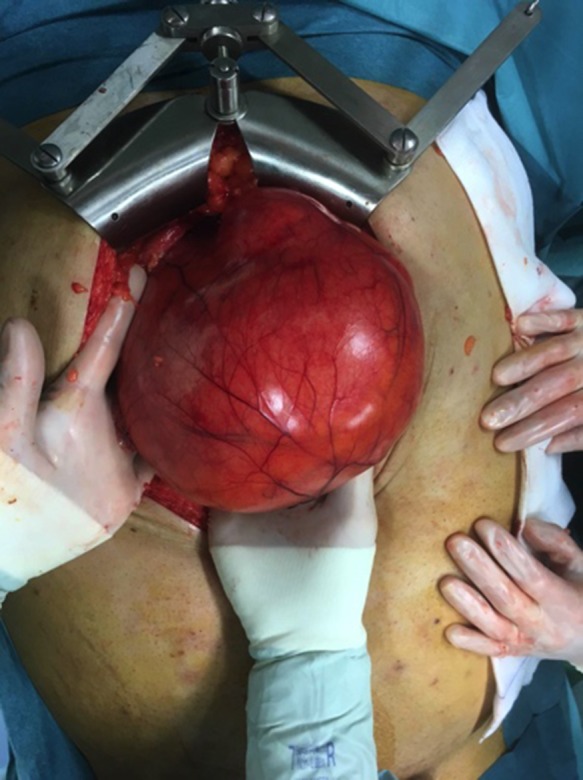
GDC full of mucus.